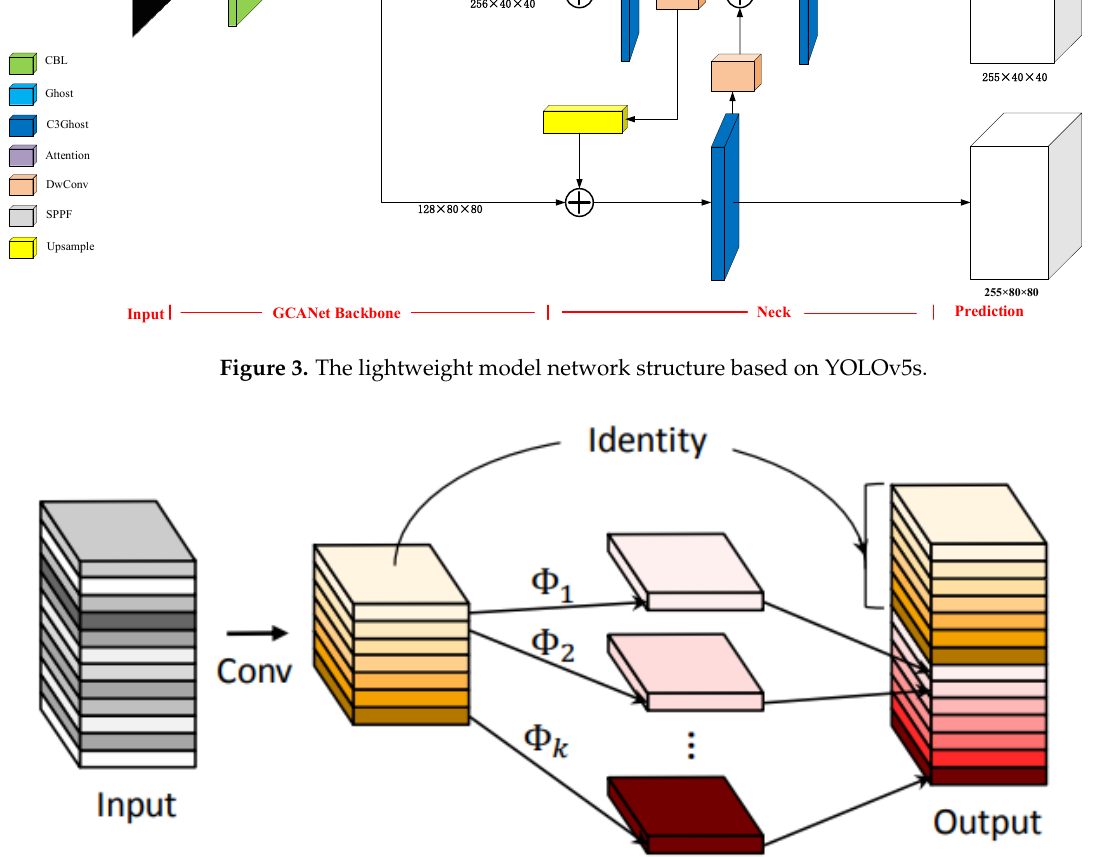
Figure 3. The lightweight model network structure based on YOLOv5s.